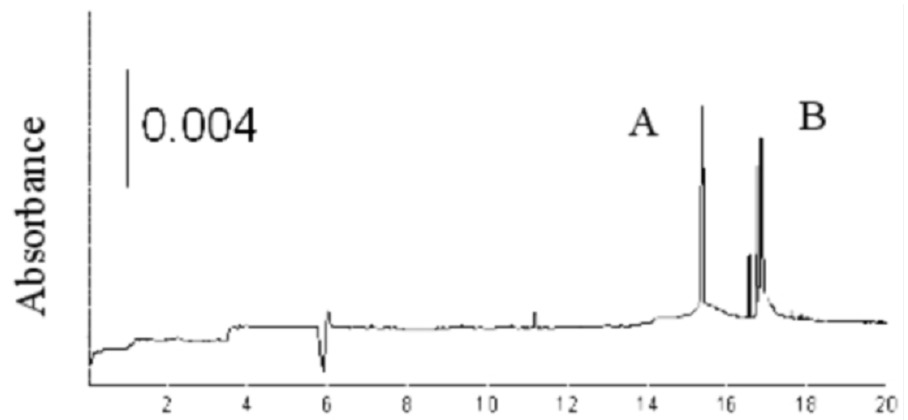
Figure 9. CZE separation of SDS-coated CdSe/ZnS/TOPO QD starting material (A) and DHLA-derivatized product (B). Separation conditions: 20 mM borate buffer, +17